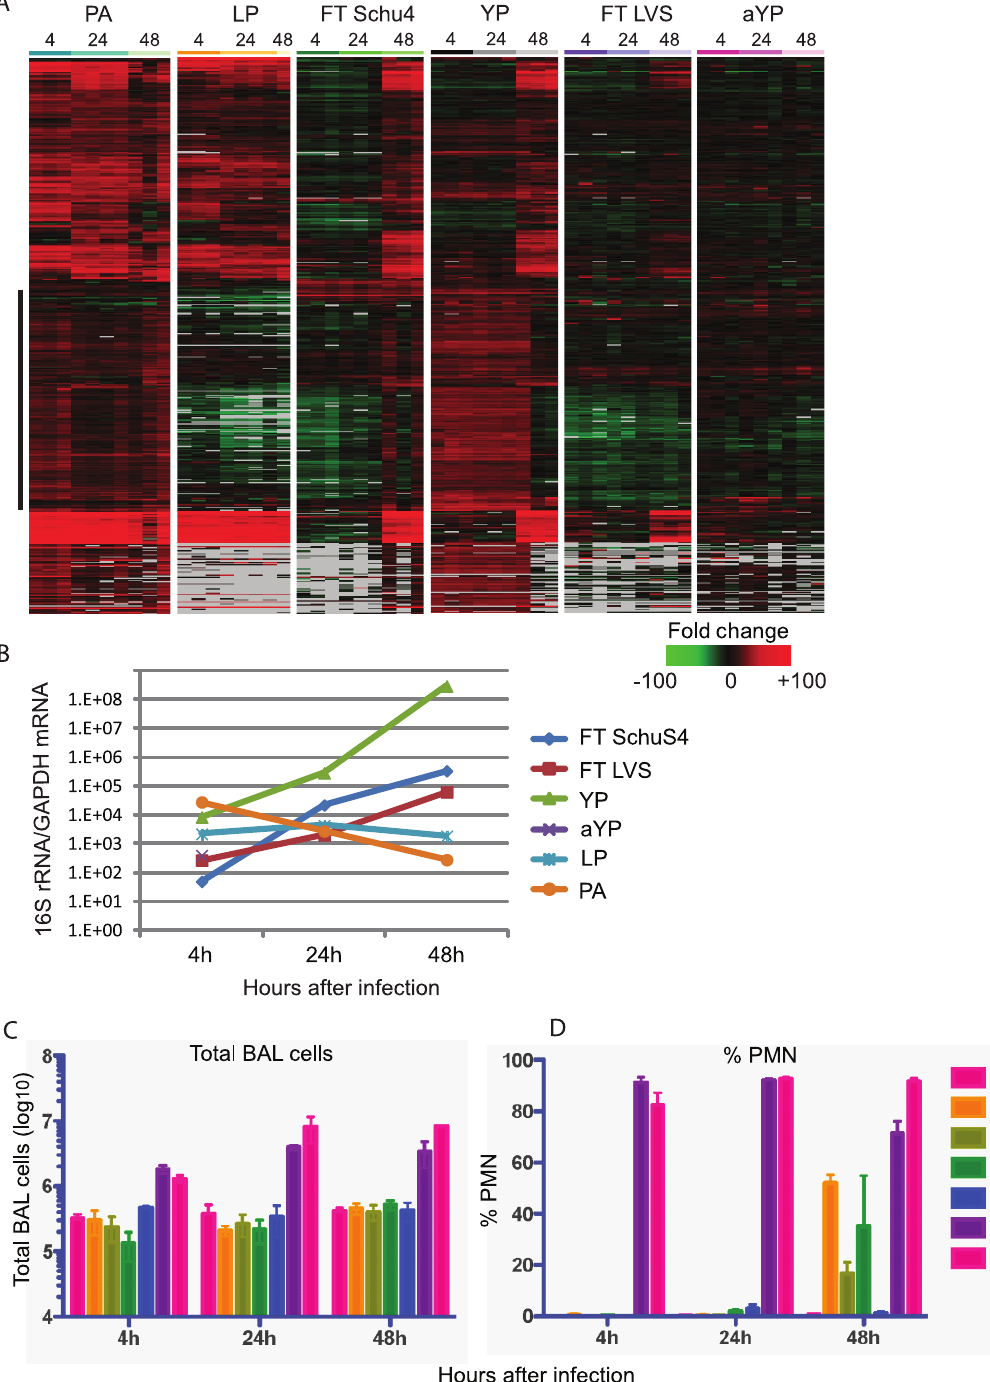
Figure 2. FT SchuS4 induces a limited pulmonary inflammatory response relative to other respiratory pathogens despite active bacterial replication during acute infection. A. Expression profiles of inflammatory mediators showing differential expression (at least 2-fold in median expression level, p value , 0.01, in at least 1 experimental condition) in lung tissue of animals exposed to respiratory pathogens. Each column represents gene expression data from an individual experiment comparing RNA from lung tissue from an infected animal to pooled RNA from lung tissue from mock-infected animals (n=9). Genes shown in red were up-regulated, genes shown in green were down-regulated and genes in black indicate no change in expression in infected relative to uninfected animals. Grey indicates no data. B . Levels of bacteria present in lung tissue represented by quantitation of 16S rRNA levels. Quantitation of total ( C ) and PMN ( D ) cells present in broncoalveolar lavage fluid from animals exposed to PBS, FT SchuS4, FT LVS, YP, aYP, LP and PA, respectively.